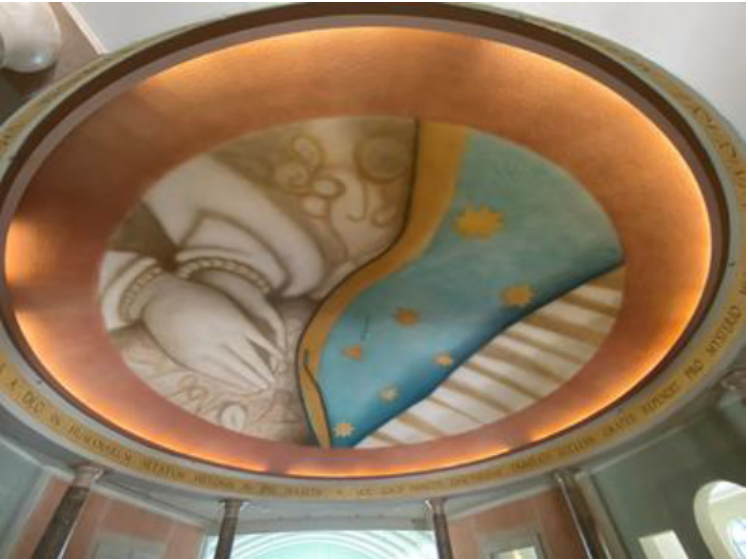
Figure 4. Hands of the Virgin of Guadalupe, Women’s Atrium, Dome (photo: Assaf Pinkus).